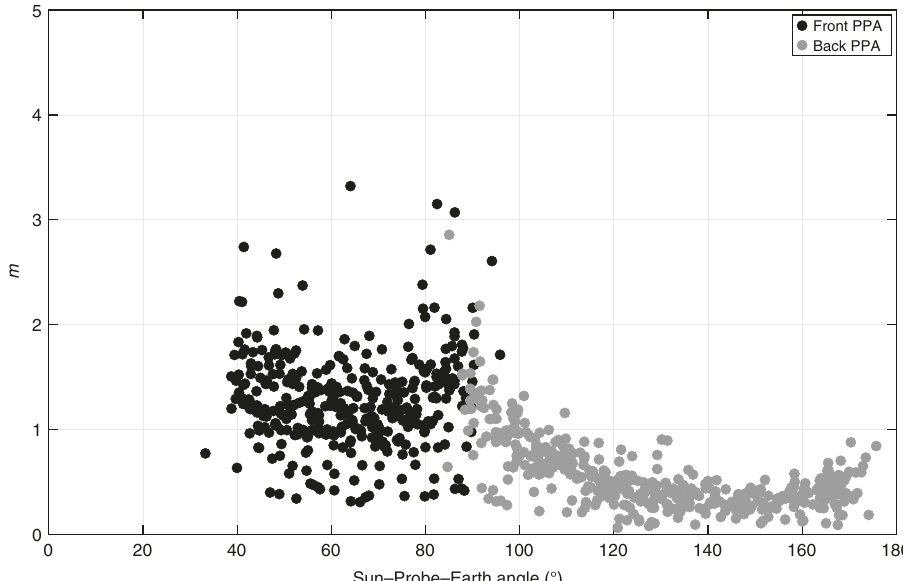
Fig. 1 Noise level of the MESSENGER range data. RMS of range measurements as a function of the Sun – Probe – Earth angle, which illustrates the effect of the solar plasma on the data noise. Lower SPE angles produce higher noise since the signal passes through dense solar plasma closer to the Sun. The data collected near superior solar conjunction (SPE < 35°) were not included in the analysis. The fi gure also shows the antennas that were used to provide the downlink to the DSN station. The range data were always collected during tracking passes with fanbeam for uplink and PPAs for downlink reducing